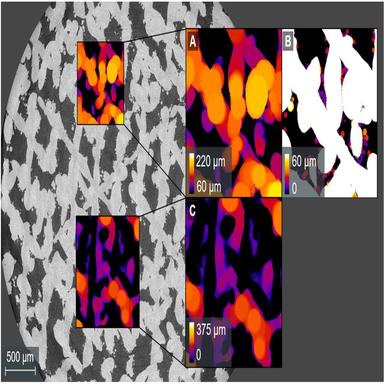
Visualization of the local thickness of sample 4 with its fused powder material structure (A), remaining particles (B) and pore network (C).